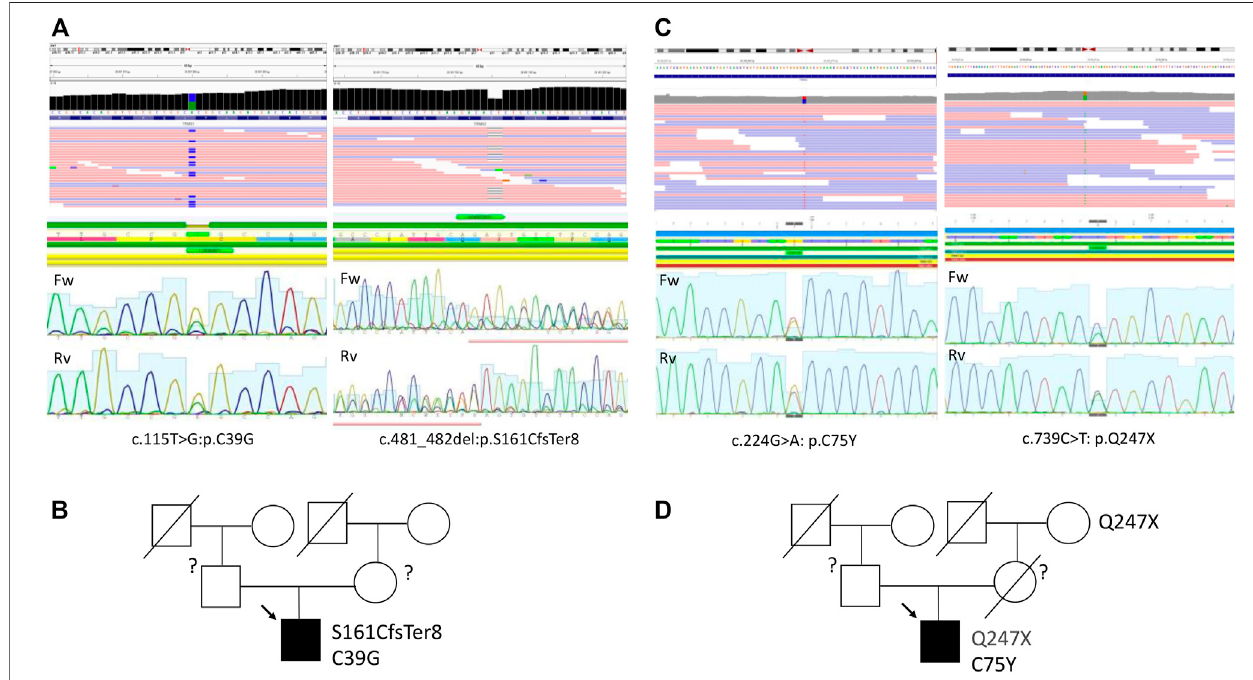
FIGURE 3 | Sequencing data and pedigree of Patient 1 (A,B) and Patient 2 (C,D) .